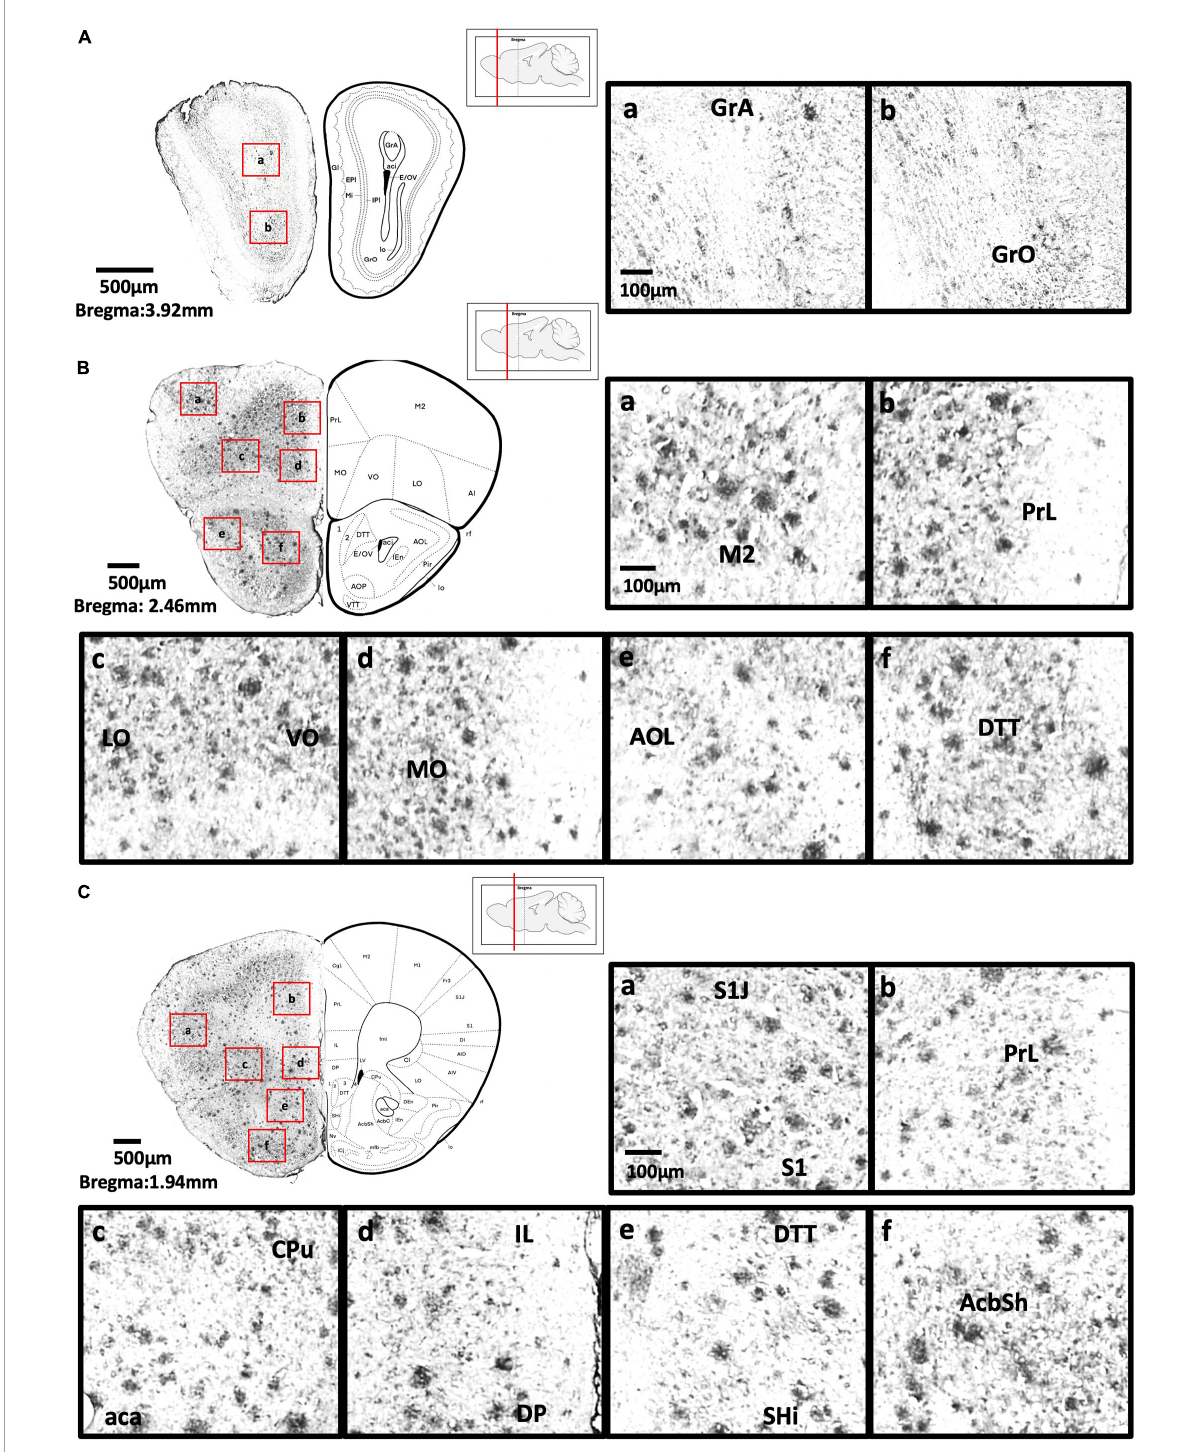
FIGURE3 (A) Coronal section of olfactory-related areas showing A β deposition in the granule cell layer of the accessory olfactory bulb (a) and granule cell layer of the olfactory bulb (b). (B) Coronal section of the frontal cortex and olfactory-related areas showing A β deposition in the secondary motor cortex (a), prelimbic cortex (b), lateral orbital cortex, ventral orbital cortex (c), medial orbital cortex (d), lateral part of anterior olfactory area (e), and dorsal tenia tecta (f). (C) Coronal section through the cerebral cortex showing A β deposition in the primary somatosensory cortex, jaw region of the somatosensory cortex (a), prelimbic cortex (b), caudate putamen, anterior part of anterior commissure (c), infralimbic cortex, dorsal peduncular cortex (d), dorsal tenia tecta, septohippocampal nucleus (e), and nucleus accumbens shell